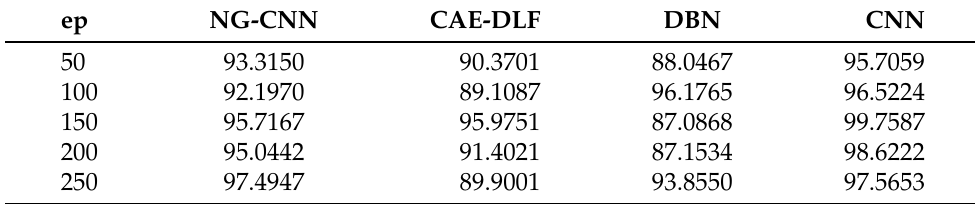
Table 2. Comparison of Precision of NG-CNN with existing methods.